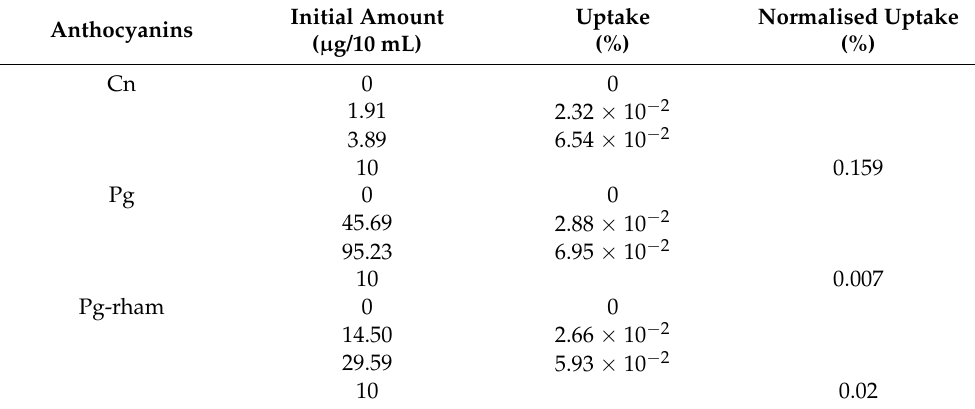
Table 1. The effect of anthocyanin structure on the uptake by Caco-2